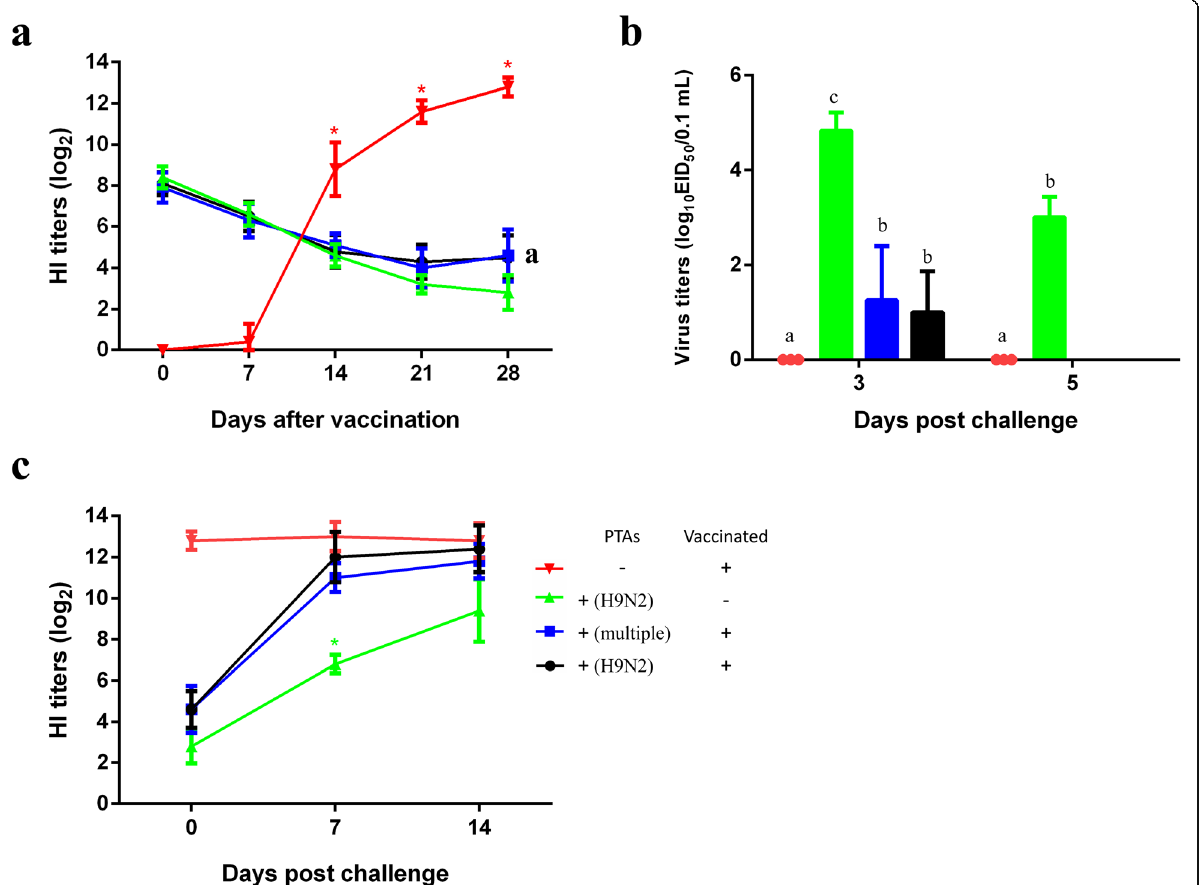
Fig. 2 Mimicking MDAs with PTAs in SPF chickens and the response to vaccination and challenge. After transferring antibodies into SPF chickens, chickens were vaccinated one day later and challenged 28 d after vaccination. Seroconversion after vaccination ( a ), viral titers in oropharyngeal swabs after challenge ( b ) and seroconversion after challenge ( c ) are shown in Fig. 2. Superscripts a-c denote differences among each group at the same time point. The symbol (*) denotes differences among groups at the same time point. P < 0.05 was considered